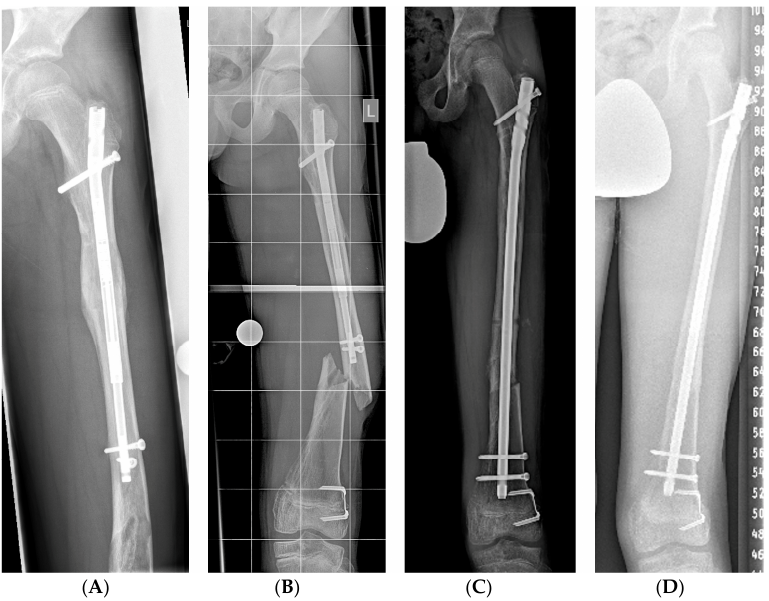
Figure 4. ( A , B ) Male patient with Ollier’s disease in whom a pathological fracture occurred at the site of an enchondroma after the lengthening procedure had been completed. ( C , D ) Stabilization of the fracture was achieved by exchange